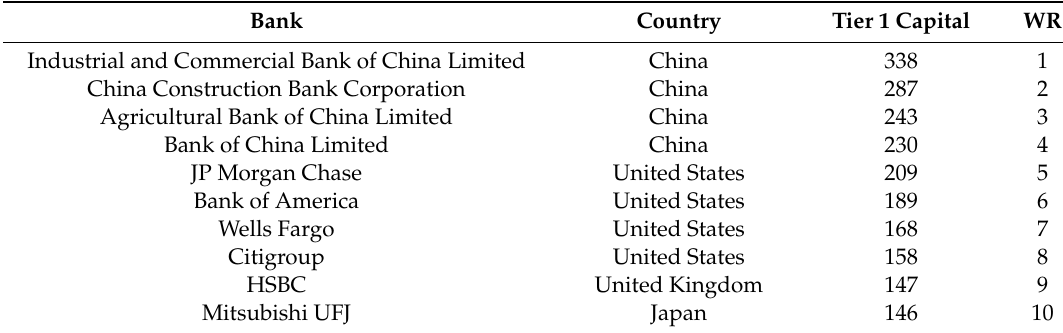
Table 2. The world rankings of the top 10 banks in the world 1